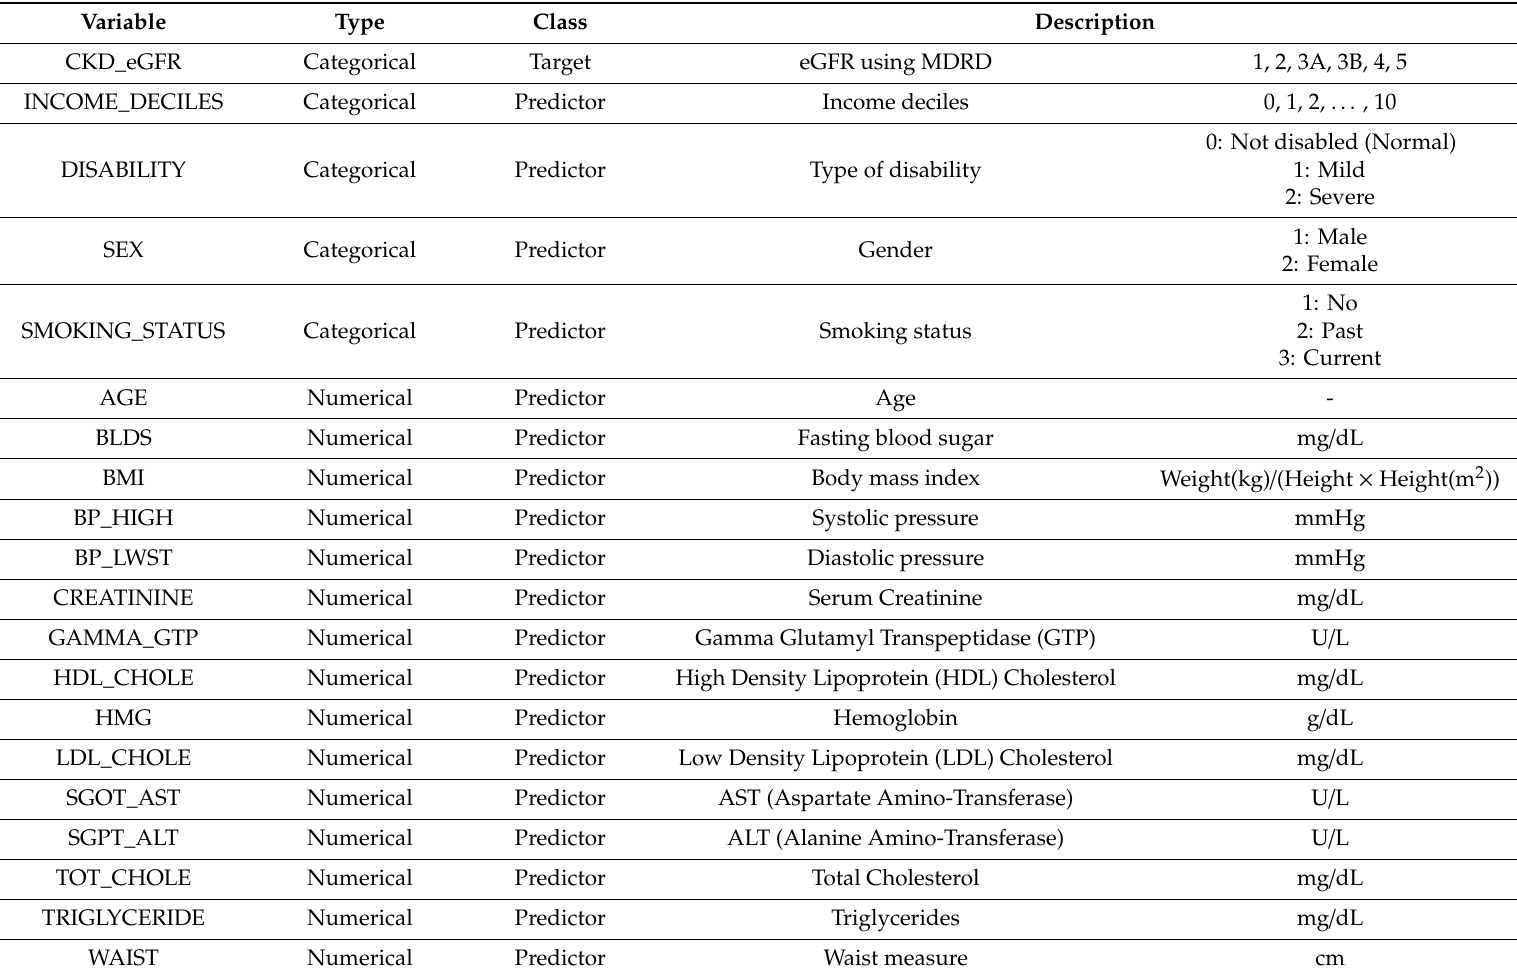
Table 1. Variable description used in the